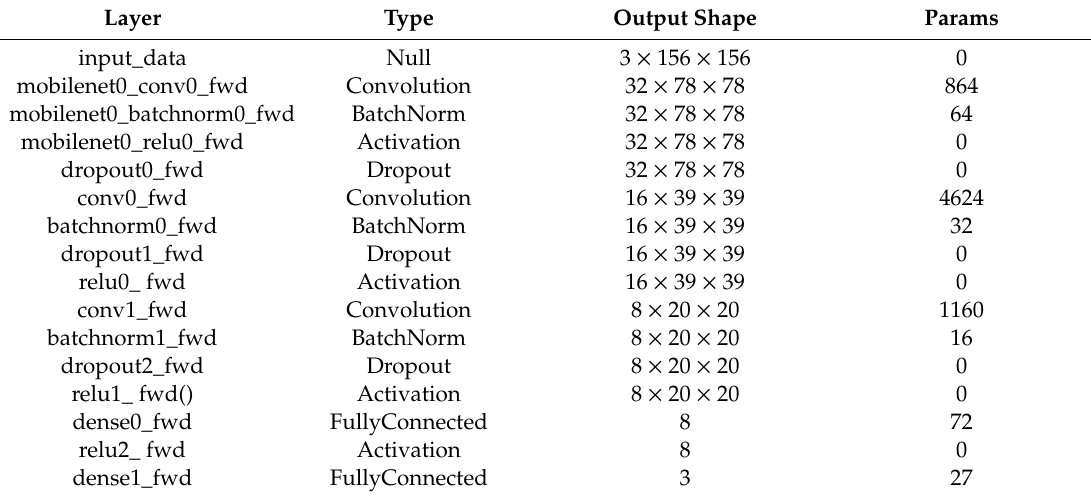
Table 1. Configuration of